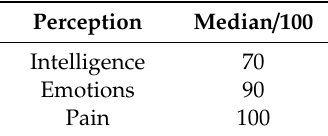
Figure 1. Answers provided to “where does your rabbit spend most of its time”; “Is your rabbit kept with a partner / partners?”; “what makes up the majority of your rabbit’s diet (over 50%)?”; “Which of the following is your rabbit provided with?” n = 1516. Table 2. Answers provided to “The ability of rabbits to experience emotions (e.g., sadness, joy, fear), intelligence, and pain the same way humans do”, between 0 and 100.